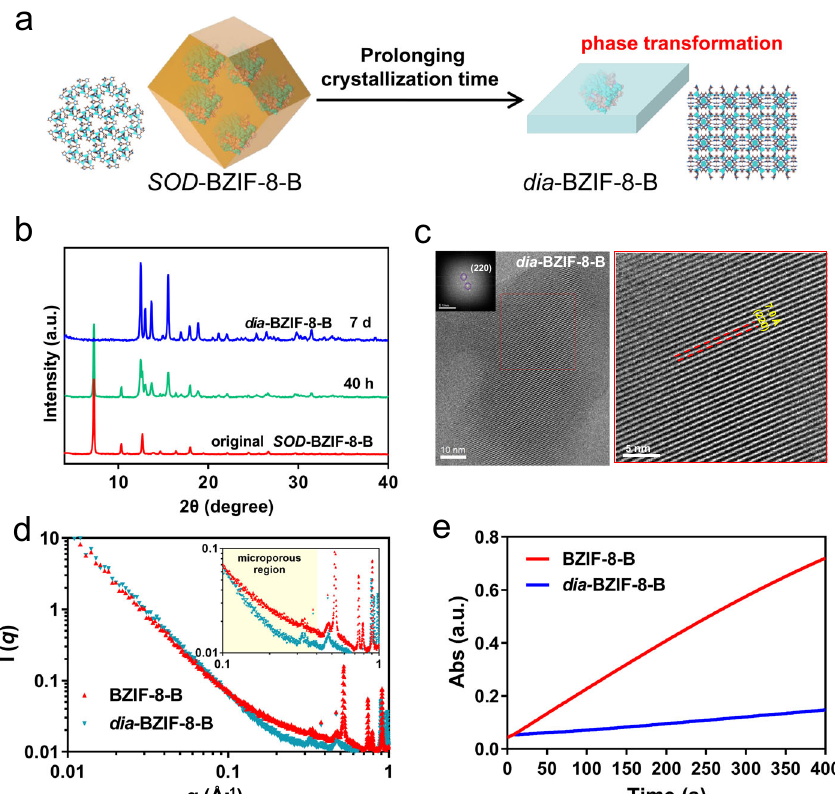
Fig. 5 Phase transformation process. a Schematic illustration of the phase transformation of SOD -type BZIF-8 when prolonging the crystallization time. b PXRD patterns of the fresh-prepared BZIF-8-B crystals, and the crystals when prolonging the crystallization time to 40 h and 7d. c The cryo-EM image showed the highly crystalline structure of dia -BZIF-8-B. d The SAXS pattern of BZIF-8-B and dia -BZIF-8-B. e The bioactivity of BZIF-8-B and dia -BZIF-8-B in terms of identical enzymes dosage (1 µ g GOx in each material).